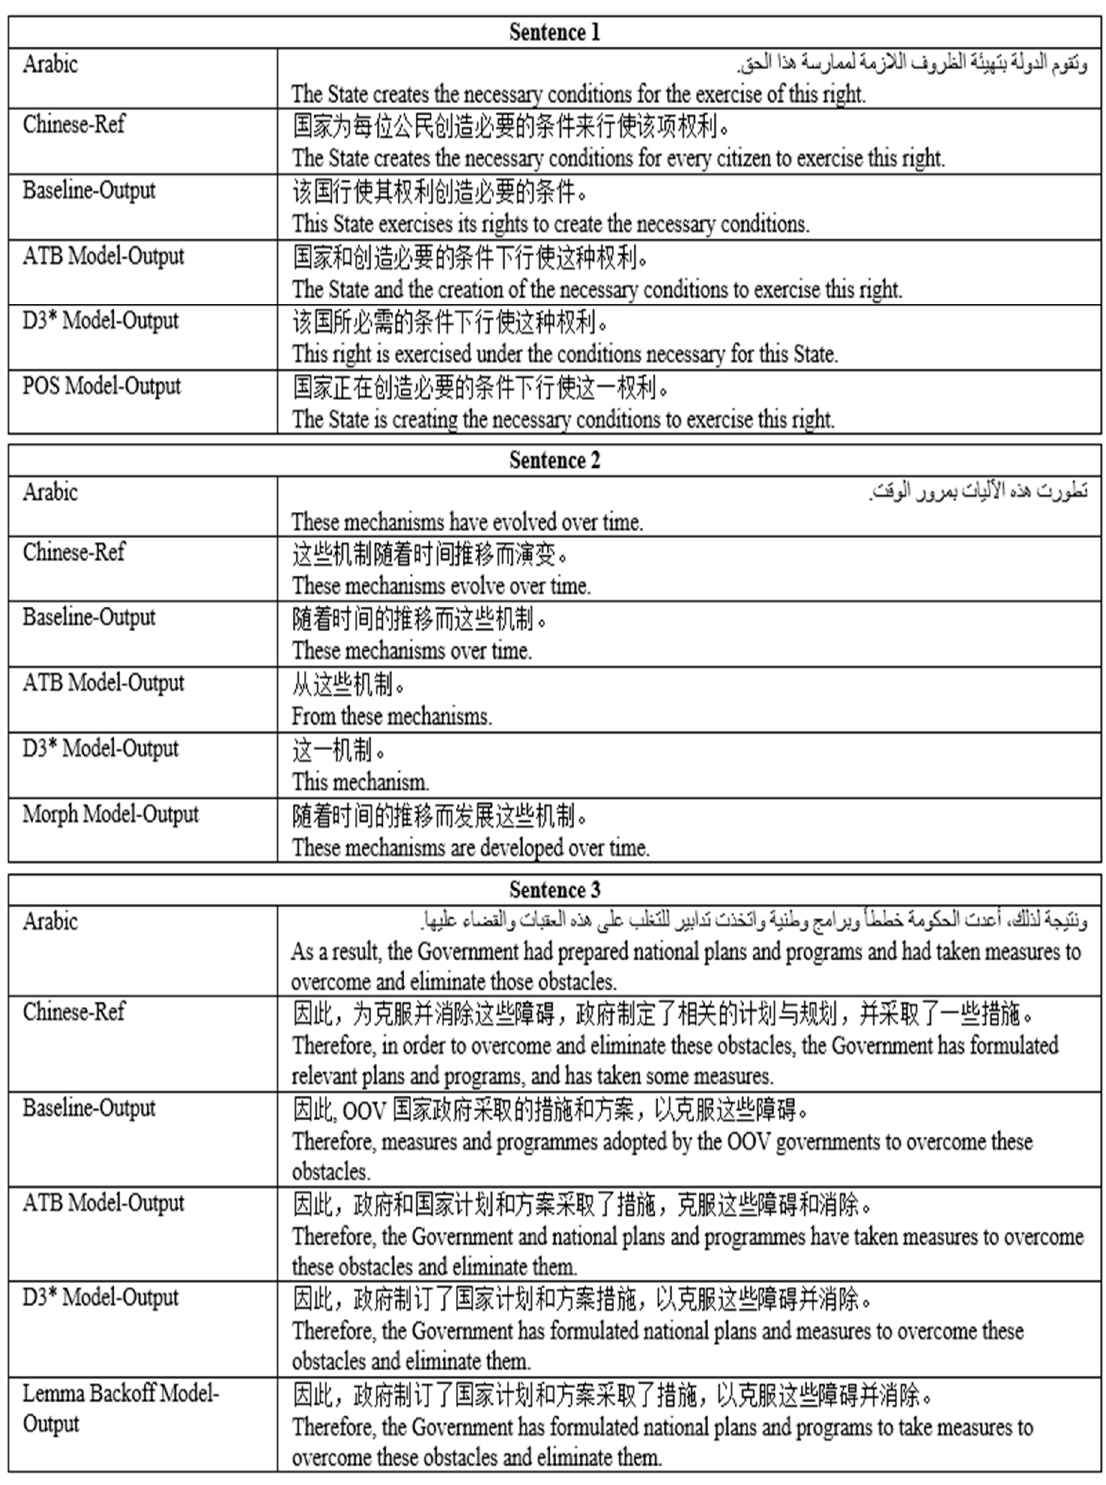
Figure 5. Examples of Arabic-to-Chinese MT output over the baseline model, tokenized models, and best-factored models. The English glosses are presented to ease readability.